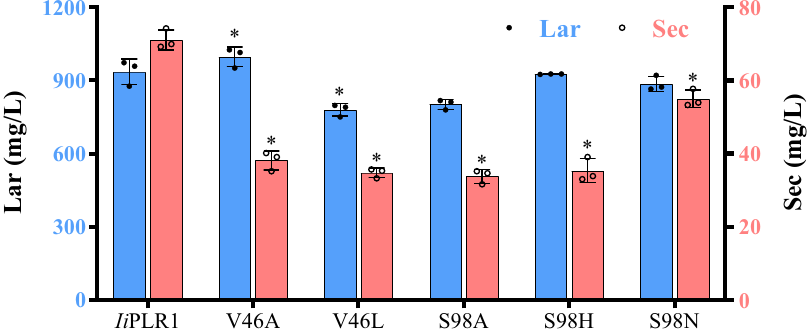
Fig. 6 Lariciresinol production through co-culture of different strains harboring a plasmid encoding Ii PLR1 or its single-site mutants with pinoresinol- producing cells. Data are mean±s.d. ( n = 3 independent experiments). Asterisk (*) indicates signi fi cant difference from the wild-type enzyme ( P < 0.05) analyzed by one-way ANOVA with Tukey ’ s multiple comparisons test. Source data are provided as a Source Data fi